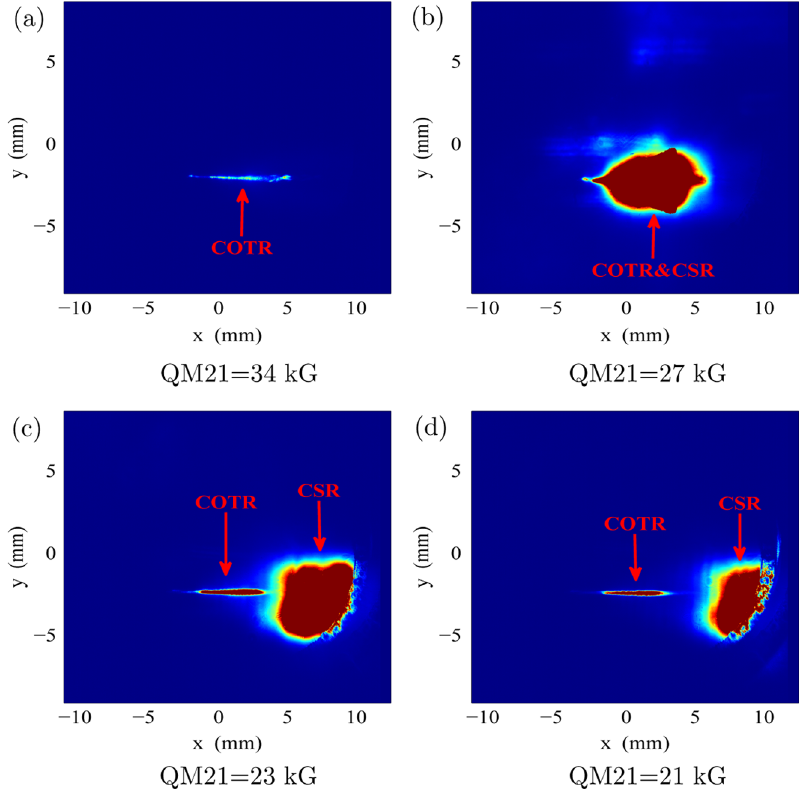
FIG. 10. (Color) Optical radiation pattern observed on an OTR screen upstream of the beginning of the third dipole in BC2 vs pre-BC2 quadrupole strength (QM21). Both COTR and CSR are detected at this screen location in (b), (c), and (d). (a) QM21 ¼ 34 kG . (b) QM21 ¼ 27 kG . (c) QM21 ¼ 23 kG . (d) QM21 ¼ 21 kG